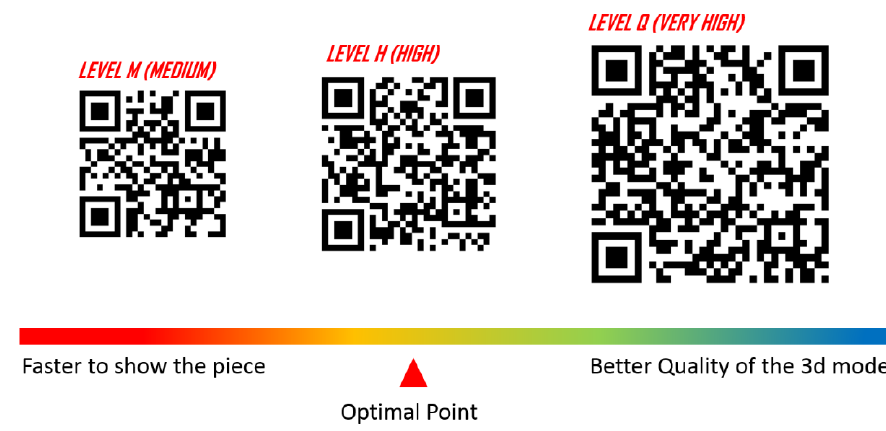
Figure 2. Di ff erent levels and qualities. Figure 2. Different levels and qualities.